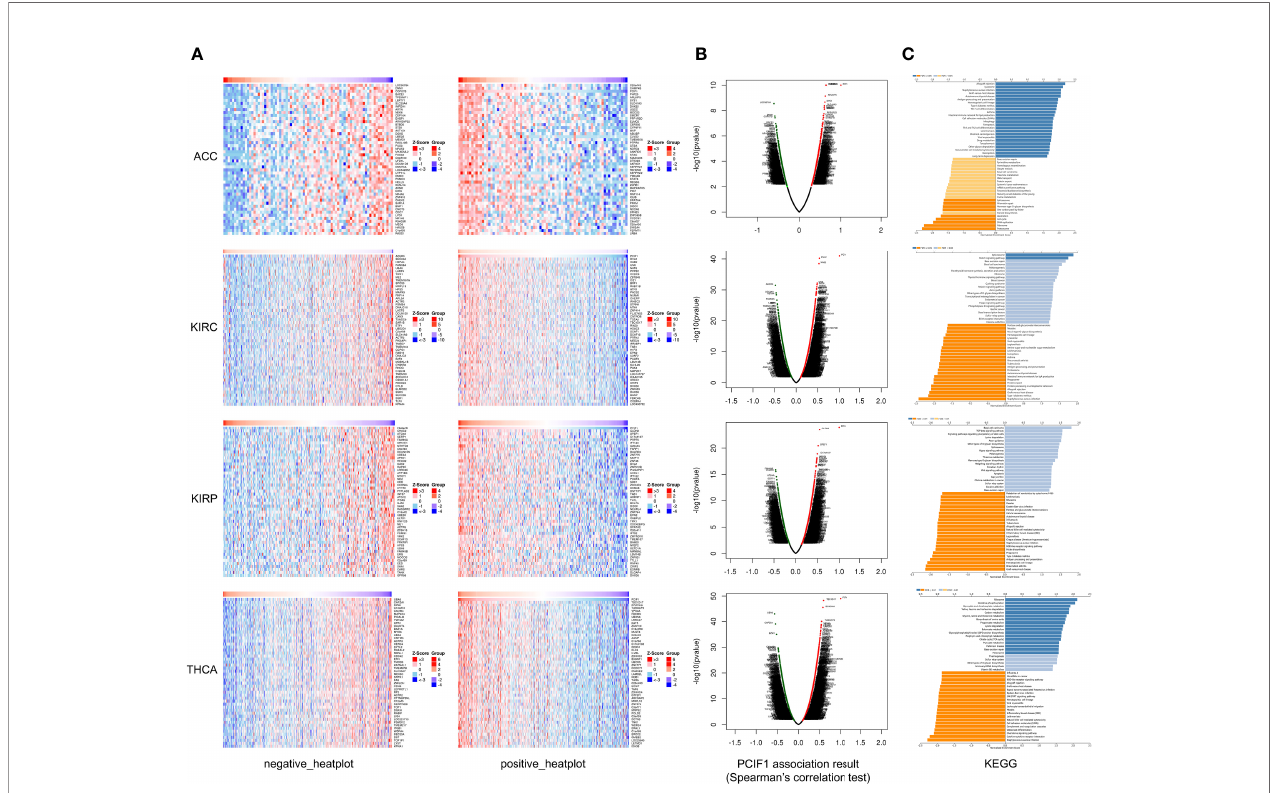
FIGURE 10 | Heatplot (A) , Spearman ’ s test (B) , and KEGG (C) analyses of PCIF1-binding proteins in ACC, KIRC, KIRP, and